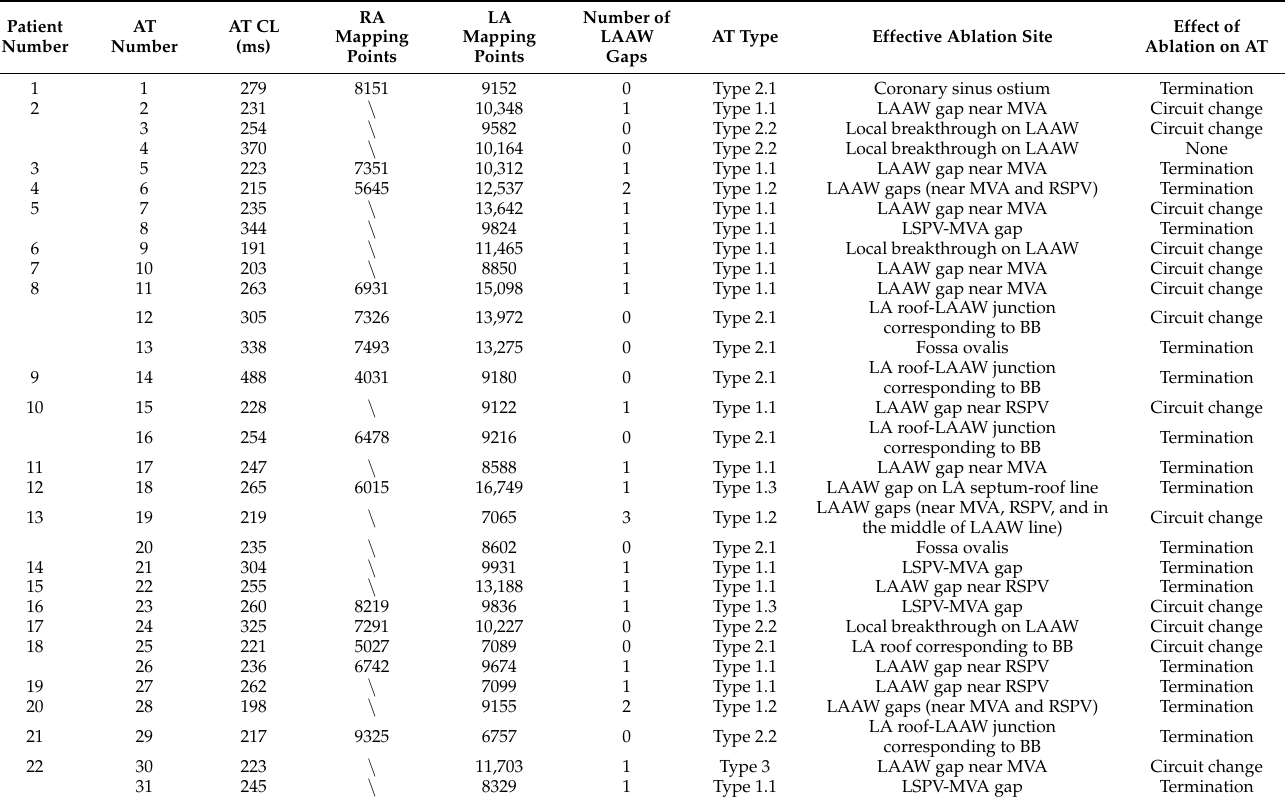
Table 2. The results of mapping and ablation of the